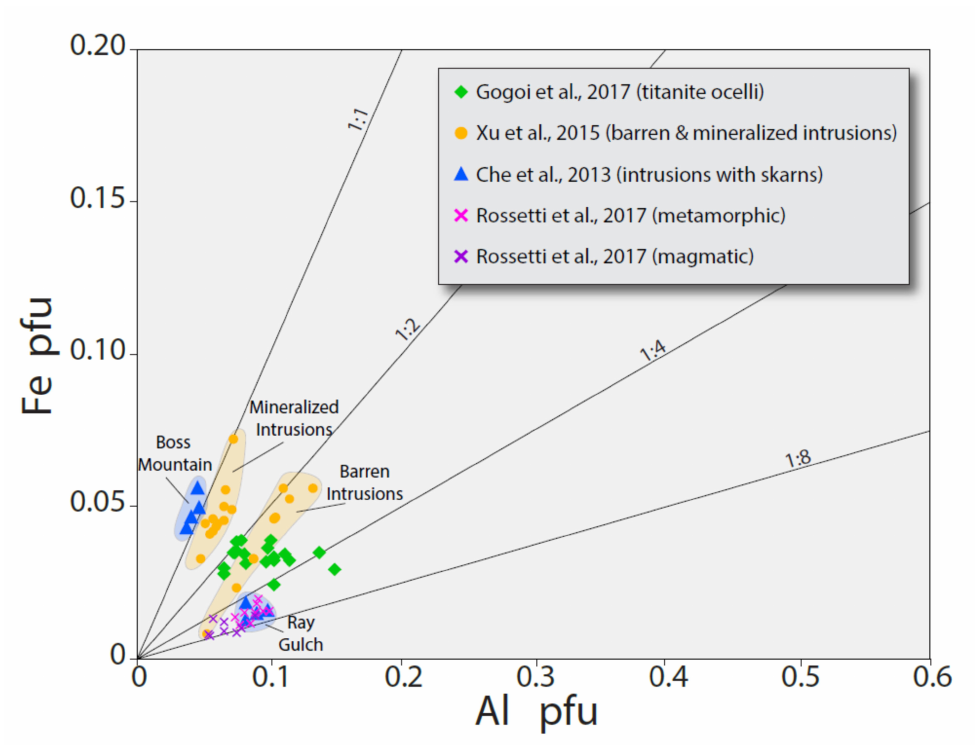
Figure 16. Fe versus Al in titanite for a few data sets where some points do not plot in the typical plutonic range (Fe/Al close to 1:1). Data sources are listed on the